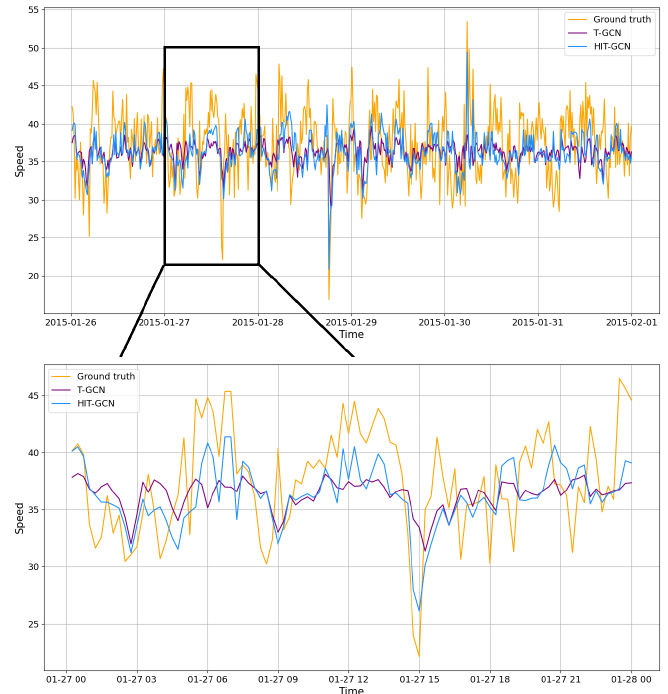
Figure 3. Comparison of prediction results of different